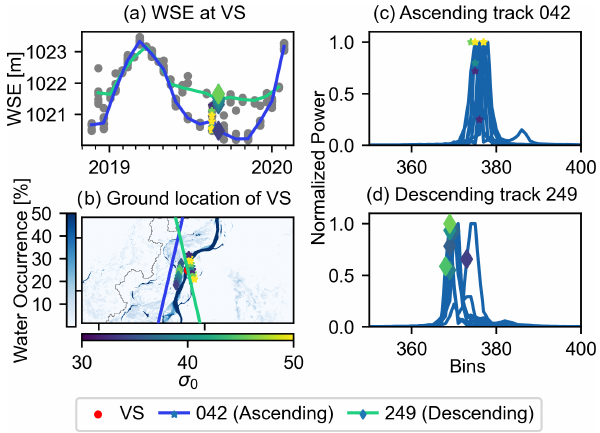
Figure 12. Demonstration of river–floodplain interactions at vir- tual station (VS) B074 on the Barotse floodplain. (a) Water surface elevation (WSE) at the VS with highlighted observations shown in (b) along with the water extent map and ground tracks. Panels (c) and (d) show waveforms from the observations from the two re- spective passes. The observations plotted are the same in (a) – (d ) to illustrate the different data dimensions (ground location, WSE and backscatter